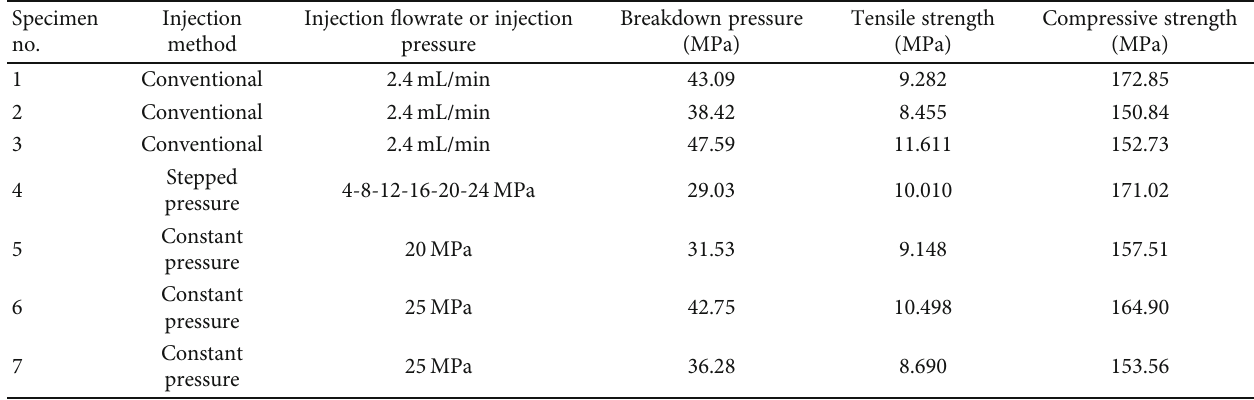
Table 1: Result summary for the fi rst batch of sandstone.